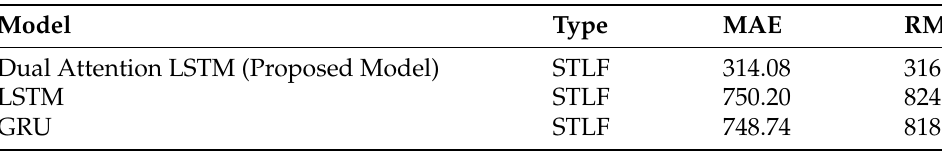
Table 6. STLF Performance in the HEDG